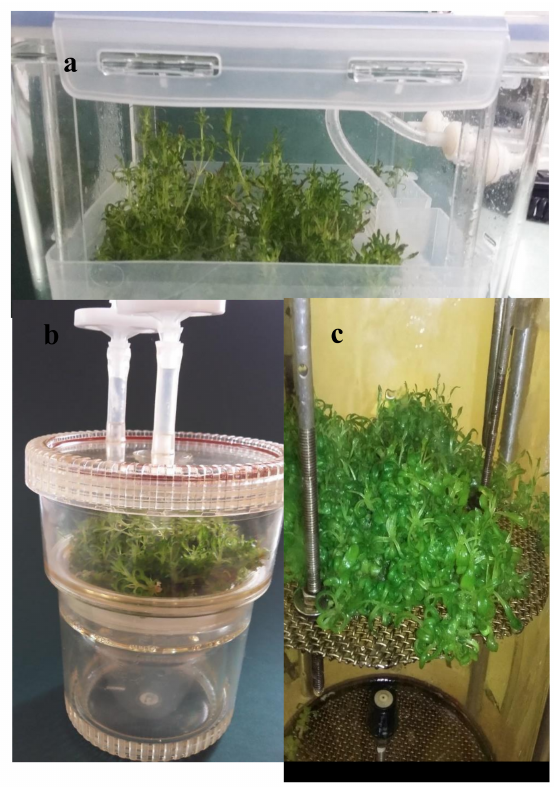
Figure 2. The D. forrestii transformed shoots grown for 3 weeks in MS medium with BPA 0.5 mg / mL and IAA 0.2 mg / mL in Plantform bioreactor ( a ), RITA ( b ) bioreactor, and nutrient sprinkle bioreactor ( c